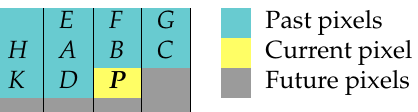
Table 2. Causal template.